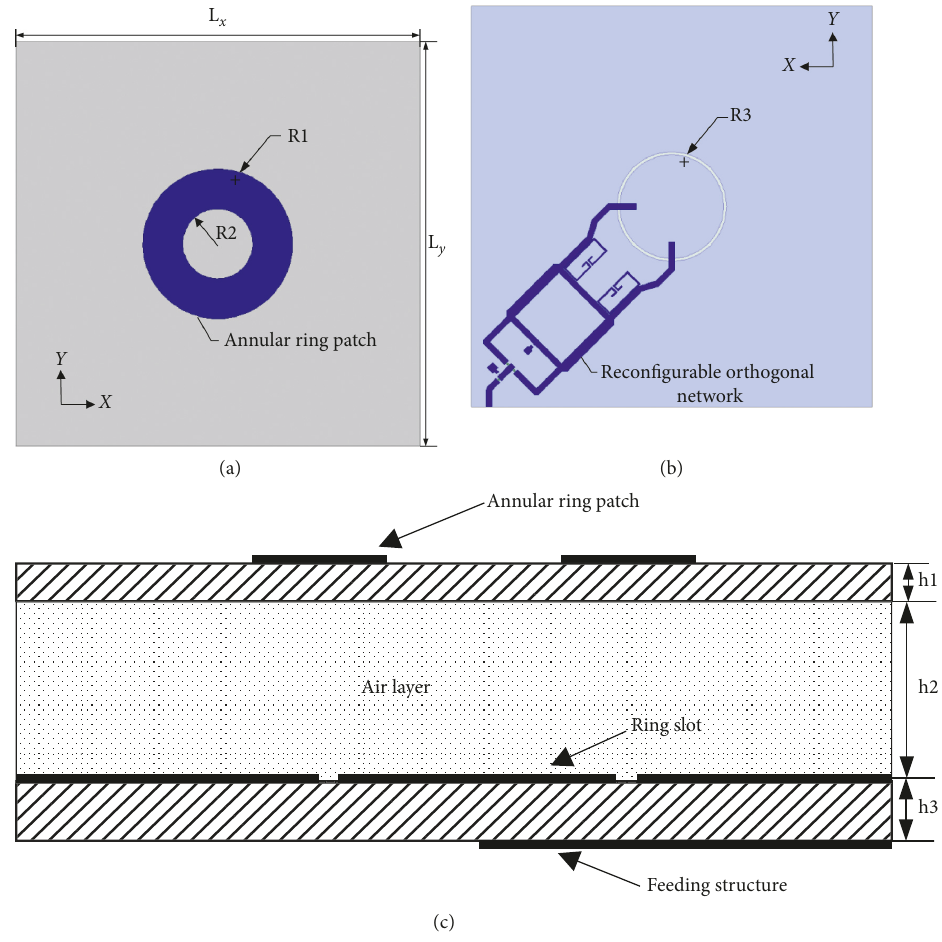
Figure 1: Geometry of the proposed antenna: (a) top view, (b) bottom view, and (c) sectional view. PIN diode